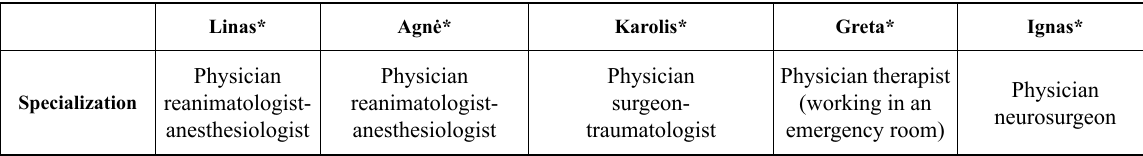
Table. Demographic characteristics of participants of the qualitative study